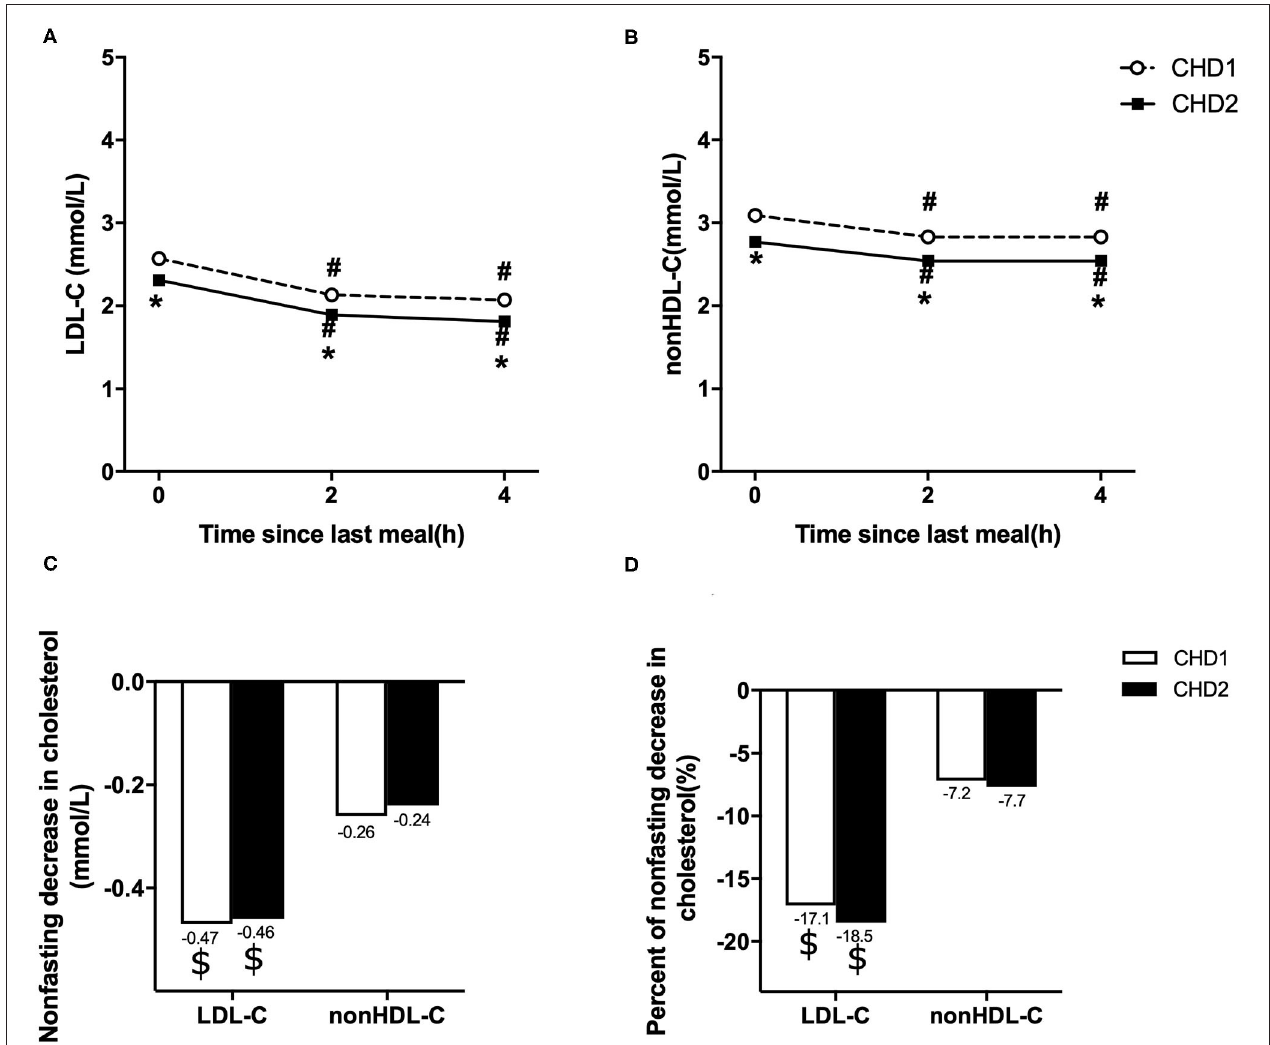
FIGURE 1 | Comparison of changes in non-fasting blood lipids in two groups. Non-fasting changes in serum levels of LDL-C (A) and non-HDL-C (B) . Values are mean ± Standard Error (SE). Comparison of non-fasting absolute reductions in LDL-C and non-HDL-C levels (C) . Comparison of non-fasting percentages of reductions in LDL-C and non-HDL-C levels (D) . CHD1 group: CHD patients taking statins < 1m and without statins treatment before admission. CHD2 group: CHD patients taking statins ≥ 1m before admission. # P < 0.05 when compared with the fasting level in the same group. * P < 0.05 when compared with CHD1 group at the same time point. $ P < 0.05 when compared with the absolute reduction or percentage of reduction in non-HDL-C